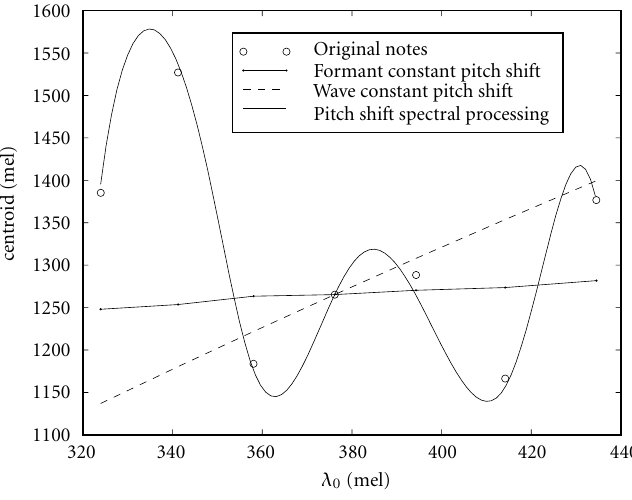
Figure 6: Spectral centroid: effect of the conversion function for pitch shifting. For a better understanding of the spectral processing importance, the centroid was computed when using the conversion function, as well as when omitting the effect of the conversion func- tion and the pitch was shifted using the wave preserving procedure or the formant preserving